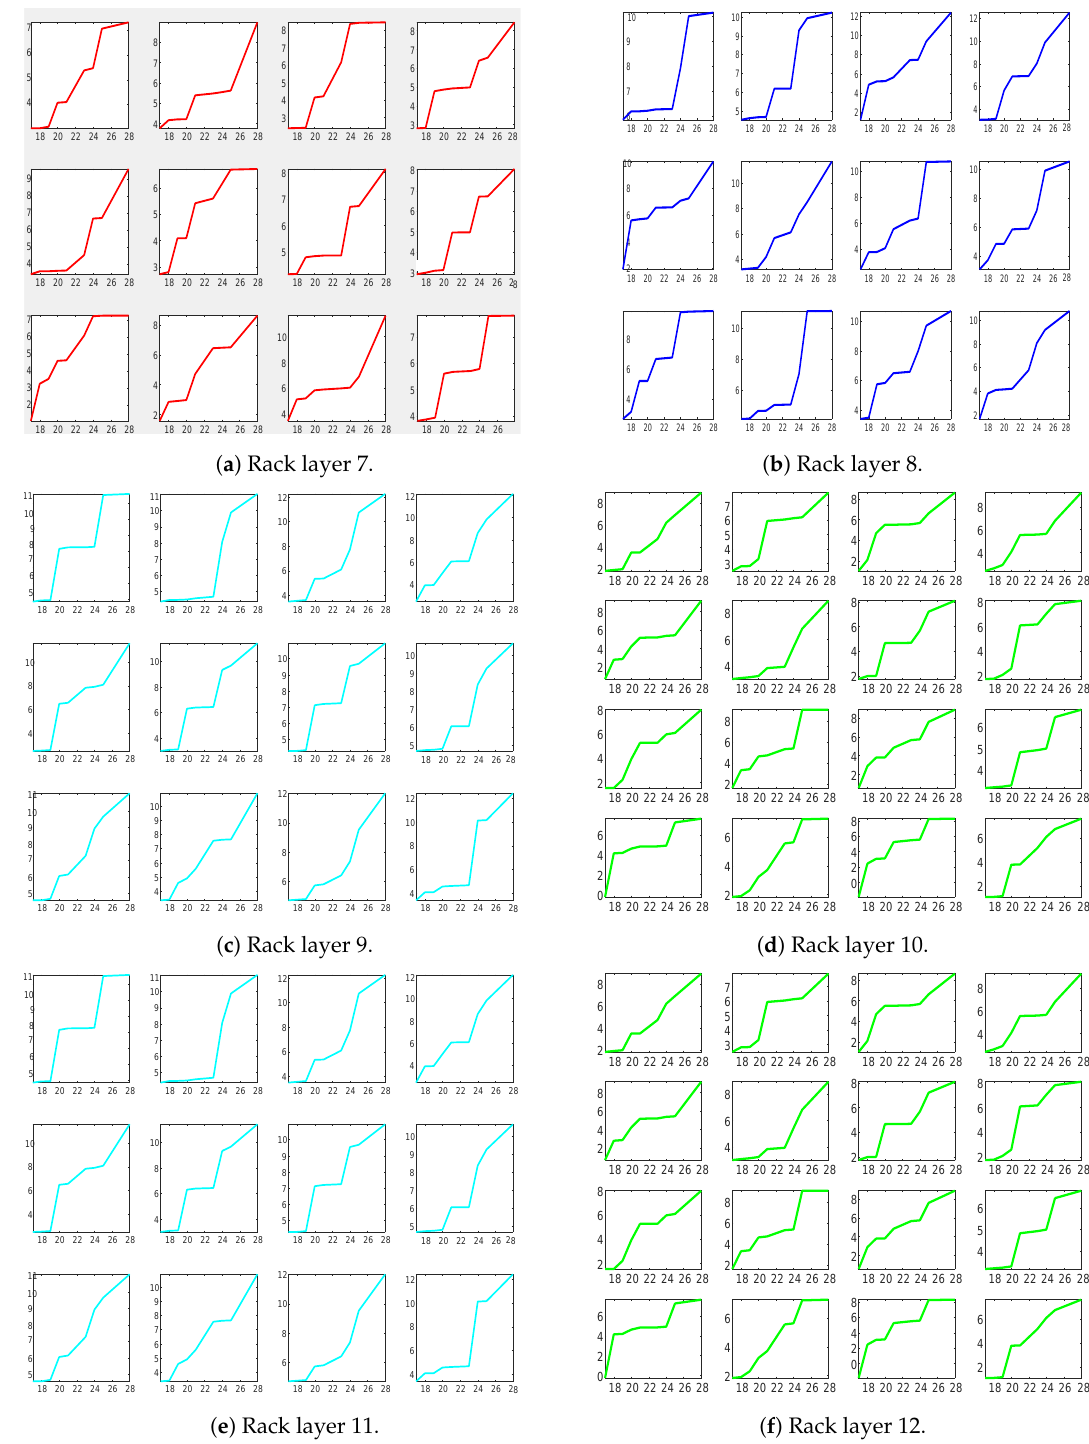
( e ) Rack layer 11. ( f ) Rack layer 12. Figure 8. Plants height trends from DAS 17 to DAS 28 for groups of four cells in each rack layer, where cells were computed as described in Section